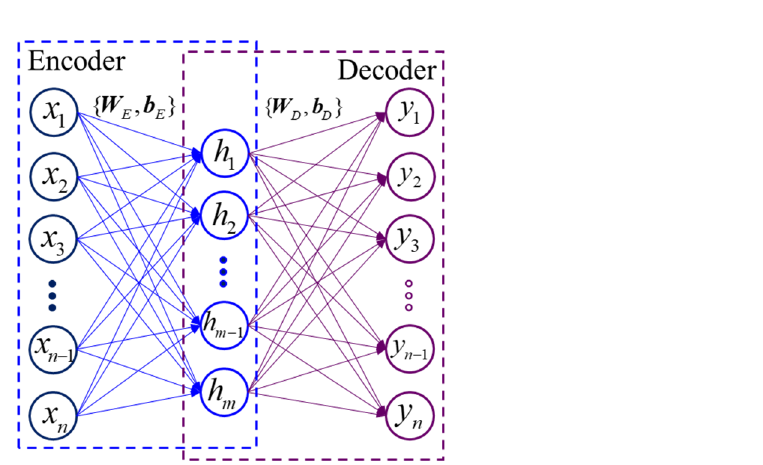
Figure 1. The principle of auto-encoder.